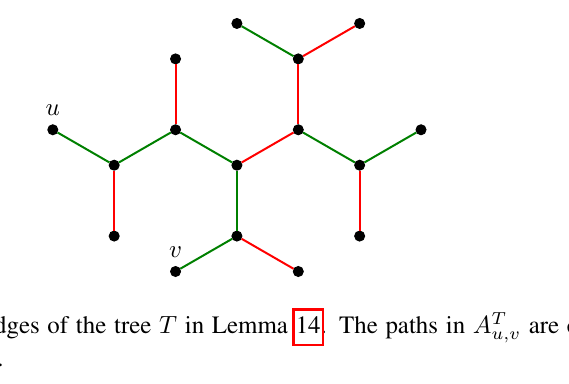
are colored green, and u,v